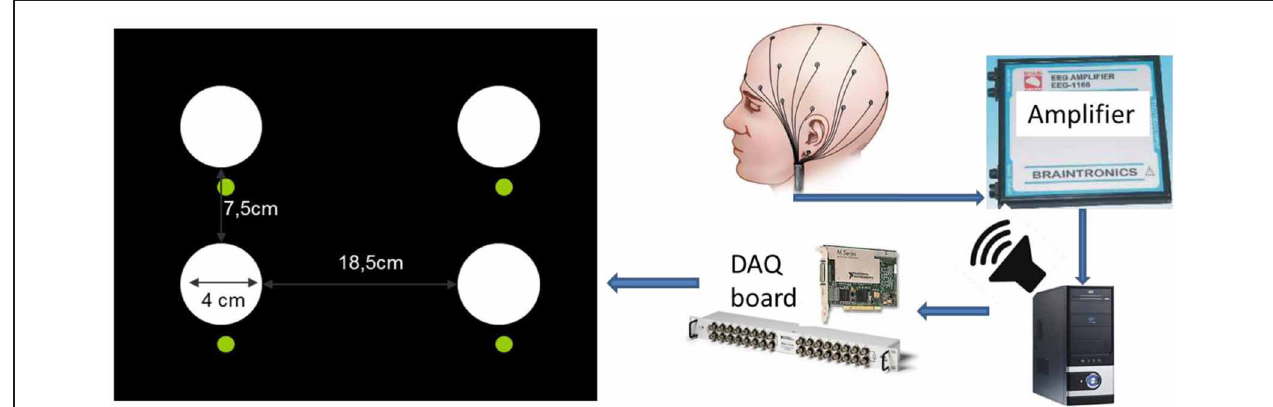
FIGURE 2 | Diagram of the BCI flicker stimulation setup (left) and the signal acquisition/stimulation system. The flickering frequency was controlled by a software driving the digital output of a National Instruments data acquisition (DAQ) board (model NI-PCI-6251 ) directly connected to the white colored LEDs, generating 0/ + 5V off vs. on signals according to the